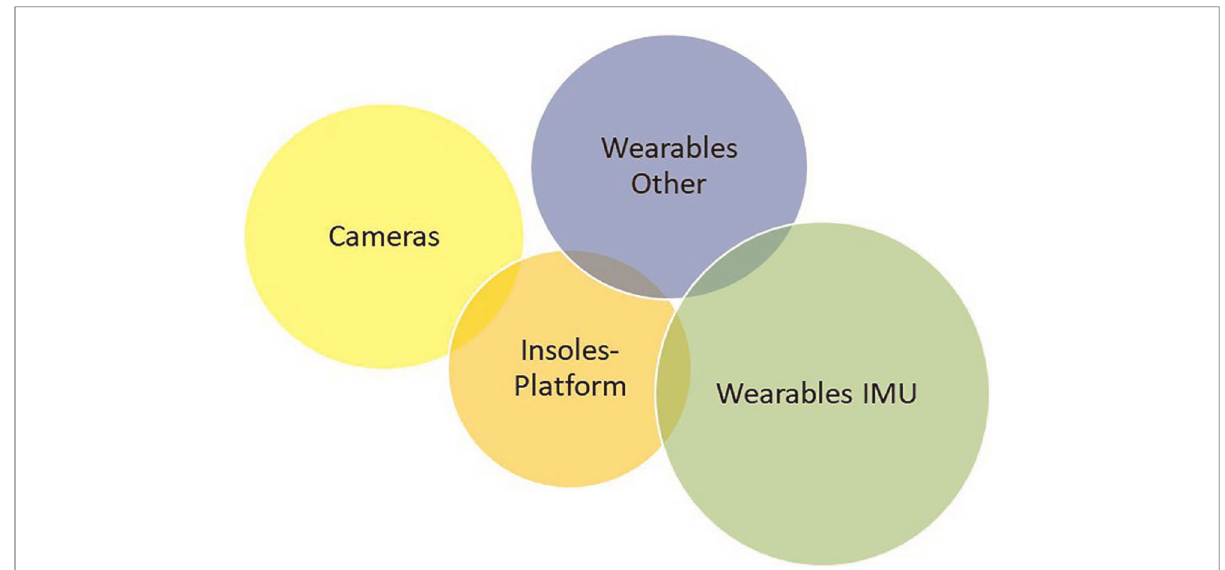
FIGURE 2 Technology results described by type category within a Venn diagram demonstrating several technologies measuring more than one category type (10.7%). IMU wearables were used the most in 25 technologies (30.1%), wearables of other varieties were used in 20 technologies (24.1%), cameras were used in 21 technologies (25.4%), and insoles or platforms were used in 17 technologies